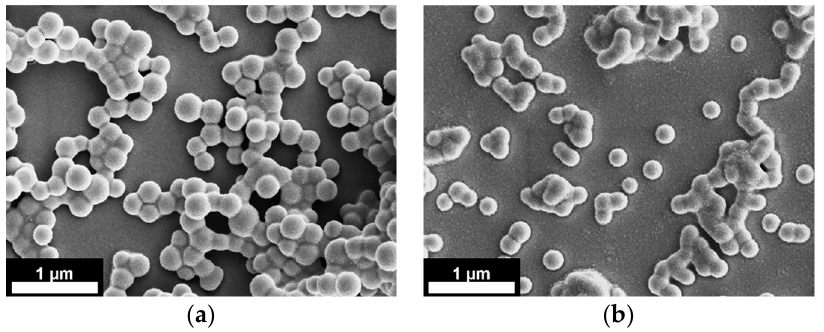
Figure 4. SEM images of nanoparticles obtained from: ( a ) 1% w / w PLGA solution at 120 bar and ( b ) 3% w / w PLGA solution at 140 bar. Applied voltage 30 kV. Scale bars 1 µm.